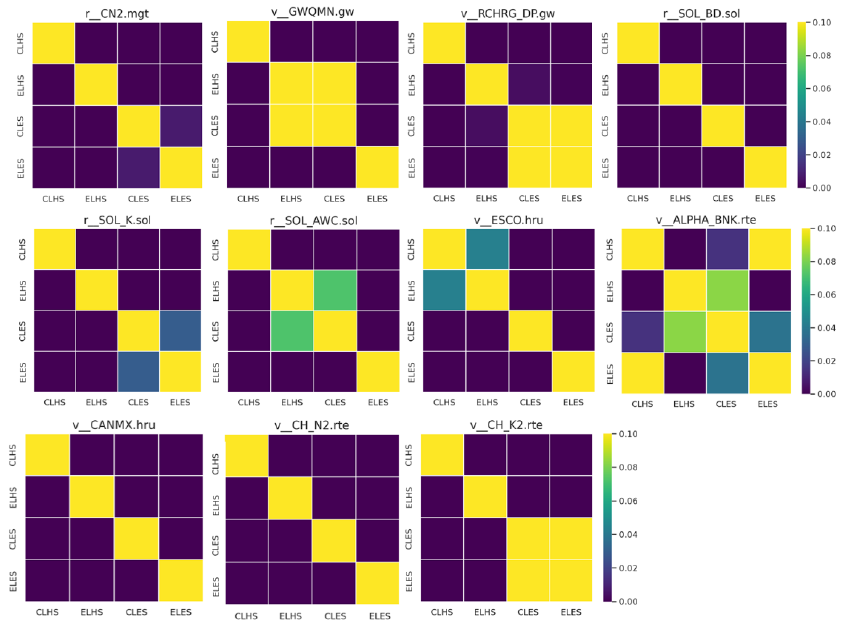
Figure A2. Boxplots of parameter range distribution of top 5% performing simulations during initial calibration. The parameter descriptions and units are listed in Table 3.